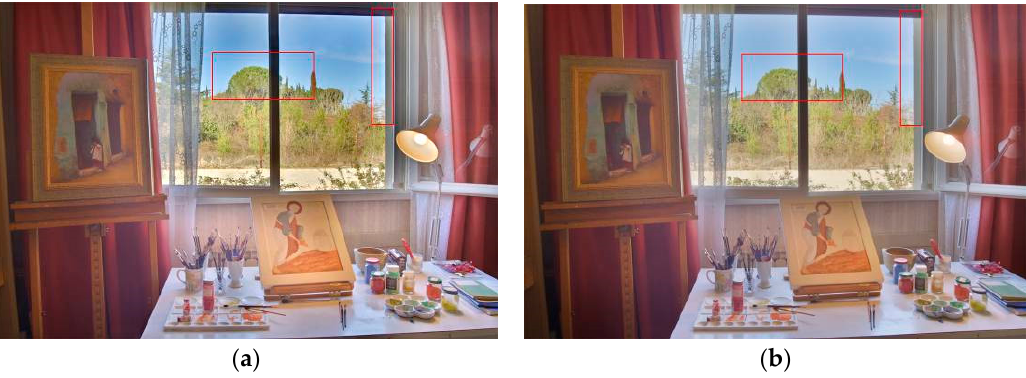
Figure 1. An example of multi-exposure image fusion. ( a ) The fused image by Li et al. [18], and ( b ) the fused image by the proposed method.